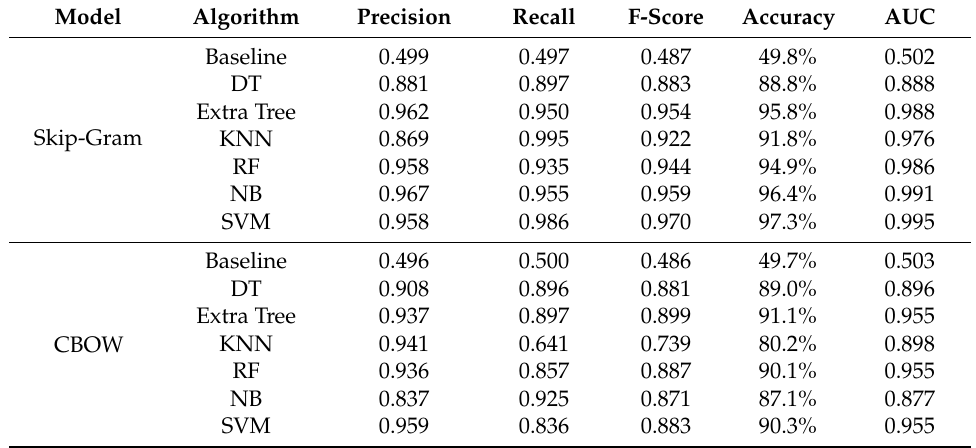
Table 8. Evaluation of classification algorithms with entity embedding models on the training dataset.